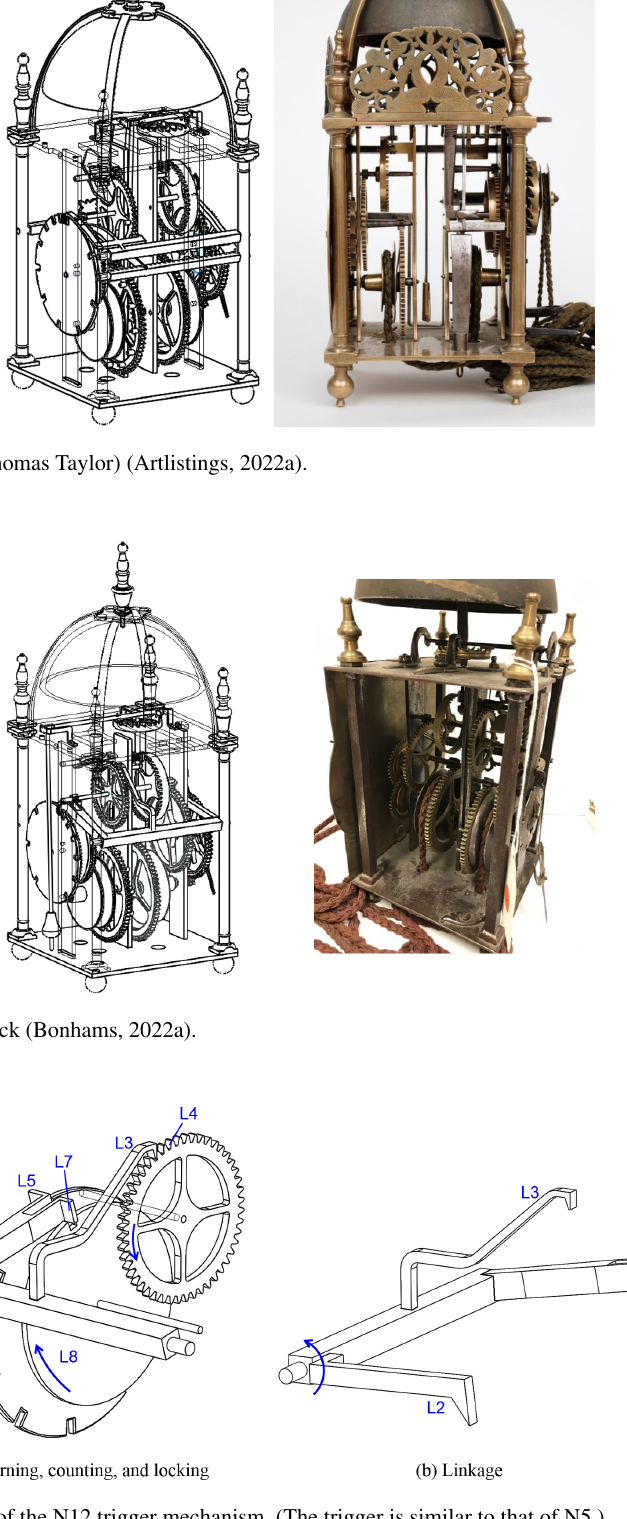
Mech. Sci., 13, 877–897,